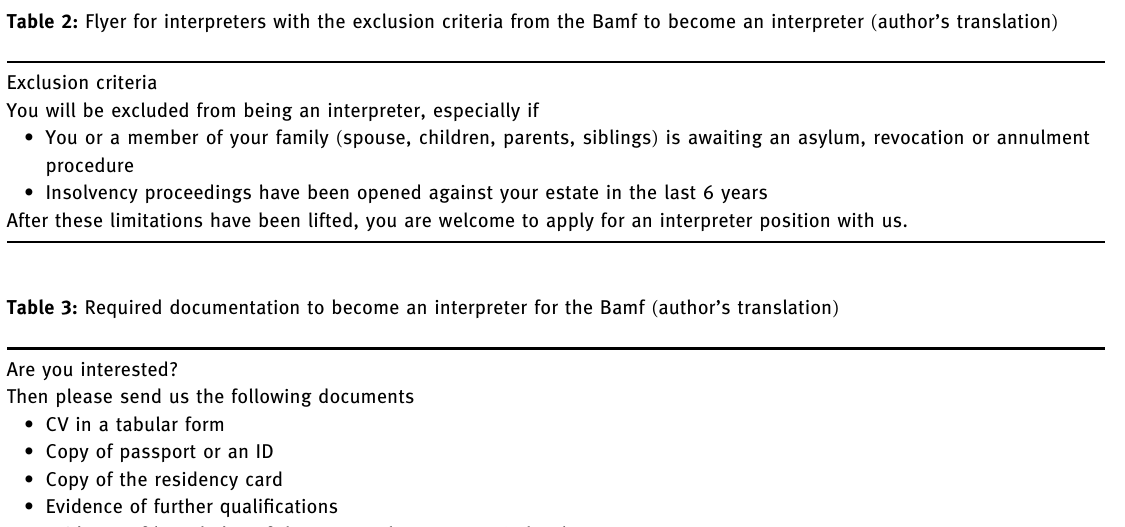
Table 2: Flyer for interpreters with the exclusion criteria from the Bamf to become an interpreter ( author ’ s translation )